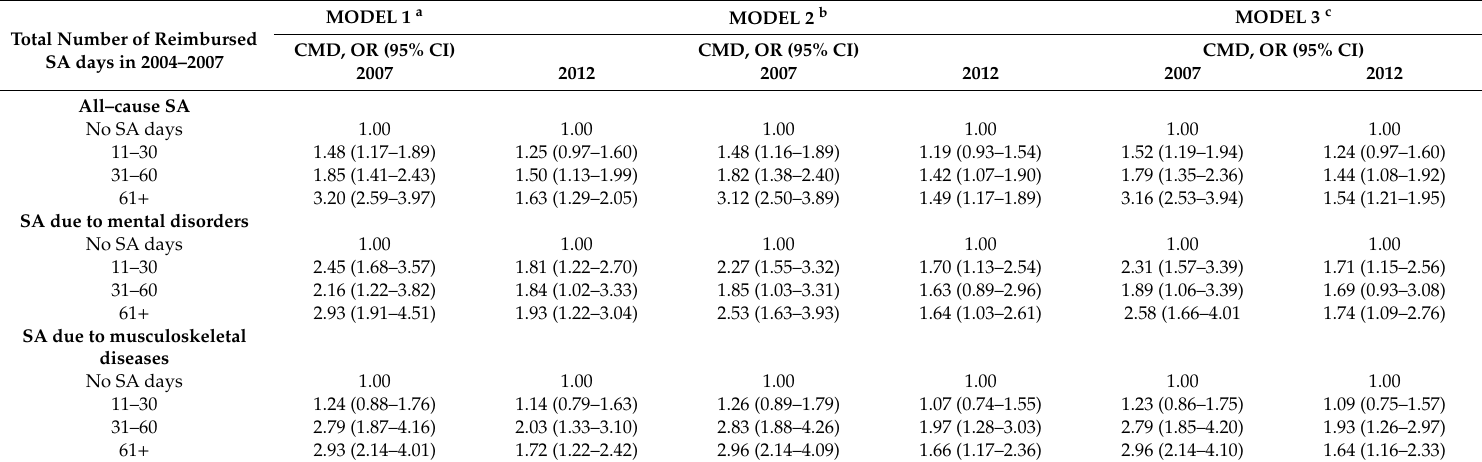
Table 3. Associations between diagnosis-specific sickness absence (SA) and subsequent common mental disorders (CMD, GHQ-12 score 3 + ), odds ratios (OR) with 95% confidence intervals (CI) from logistic regression models. ( N =